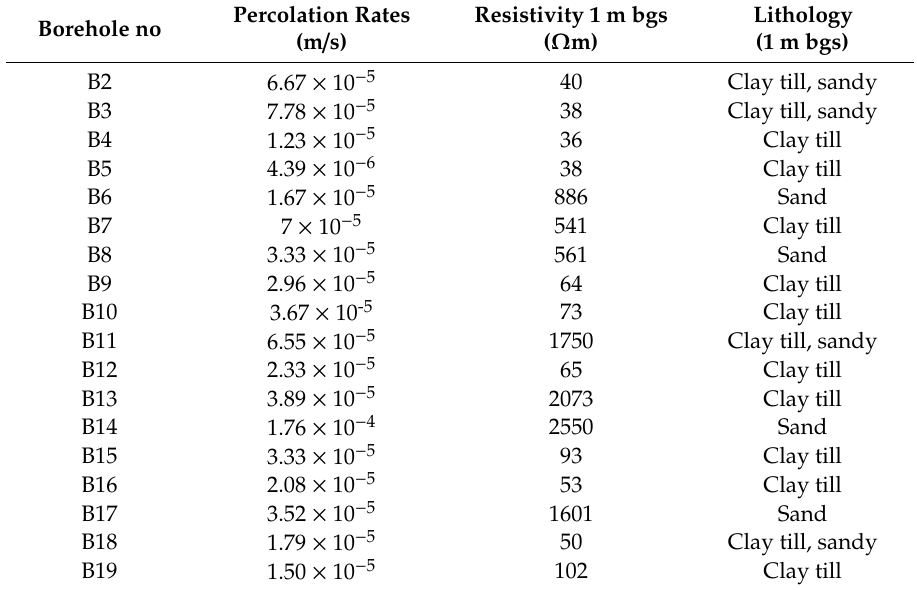
Table 2. Boreholes, Measured Percolation Rates, Nearest Resistivity and Lithology for the 18 Drillings at the Provstlund Site.